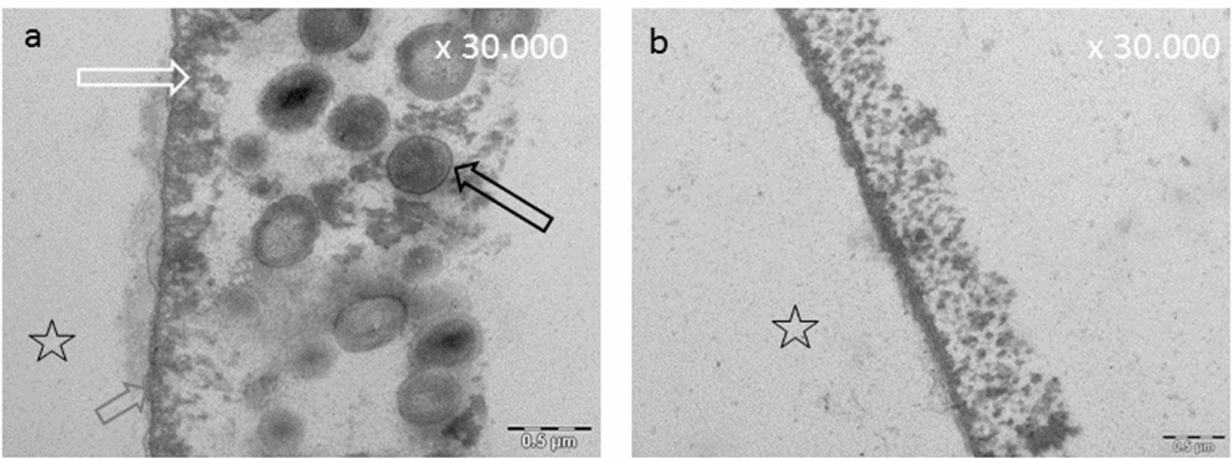
Figure 10. Sustainable long-term effects of tannic acid on bioadhesion and biofilm formation in situ, TEM. After 24 h of oral exposure, bacterial biofilm formation was observed ( a , b ) as also described in Xi et al. (2020) [259]. ( a ) shows an image of the control without rinsing. The basal pellicle layer is marked with a grey arrow, the globular pellicle layer is marked with a white arrow and the bacterial cell is marked with a black arrow. Tannic acid modified pellicle is covered by bacteria and extracellular biofilm matrix ( b ). The volunteers rinsed with a solution containing 1% tannic acid and 1% chinese gallnut extract, 2 times a day. The first time 3 min after the splint was inserted, the second time before night sleeping. As also seen in Figure 9, aggregates enriched from the saliva can be observed above the pellicle. The former enamel site was marked with an